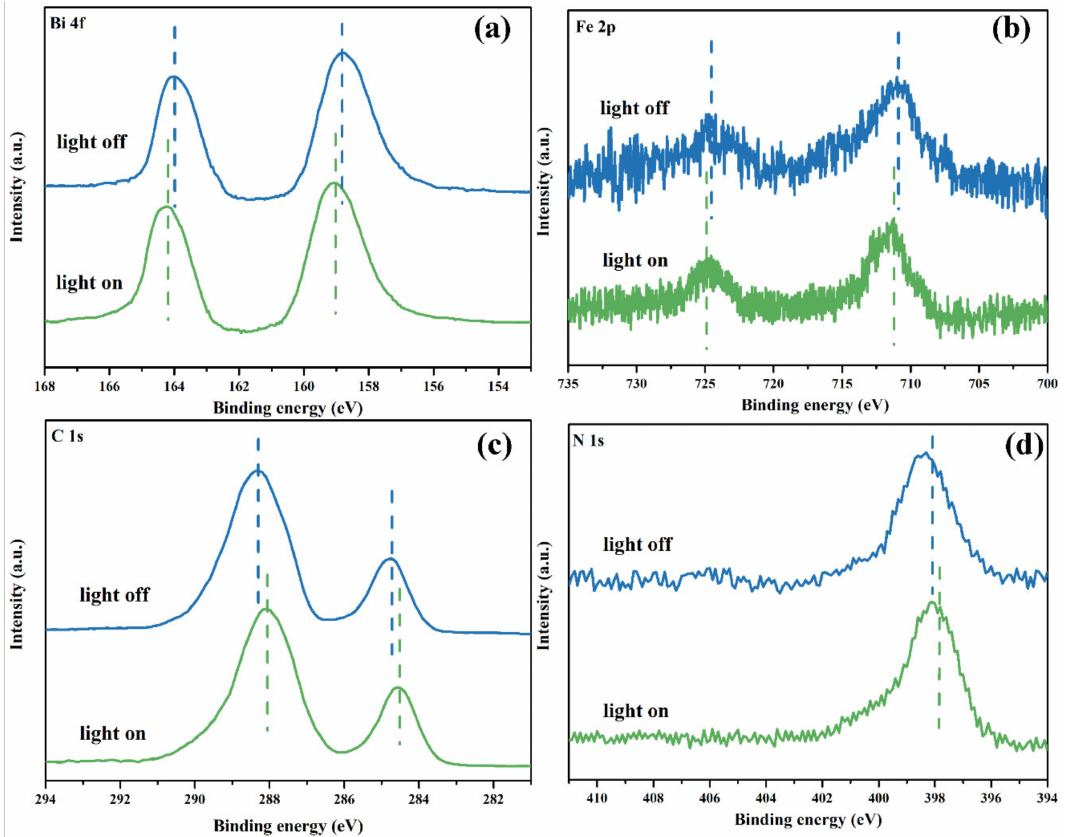
Figure 13. XPS spectra of BiFeO/g-C 3 N 4 in the dark and light irradiation: ( a ) Bi 4f, ( b ) Fe 2p, ( c ) C 1s, ( d ) N